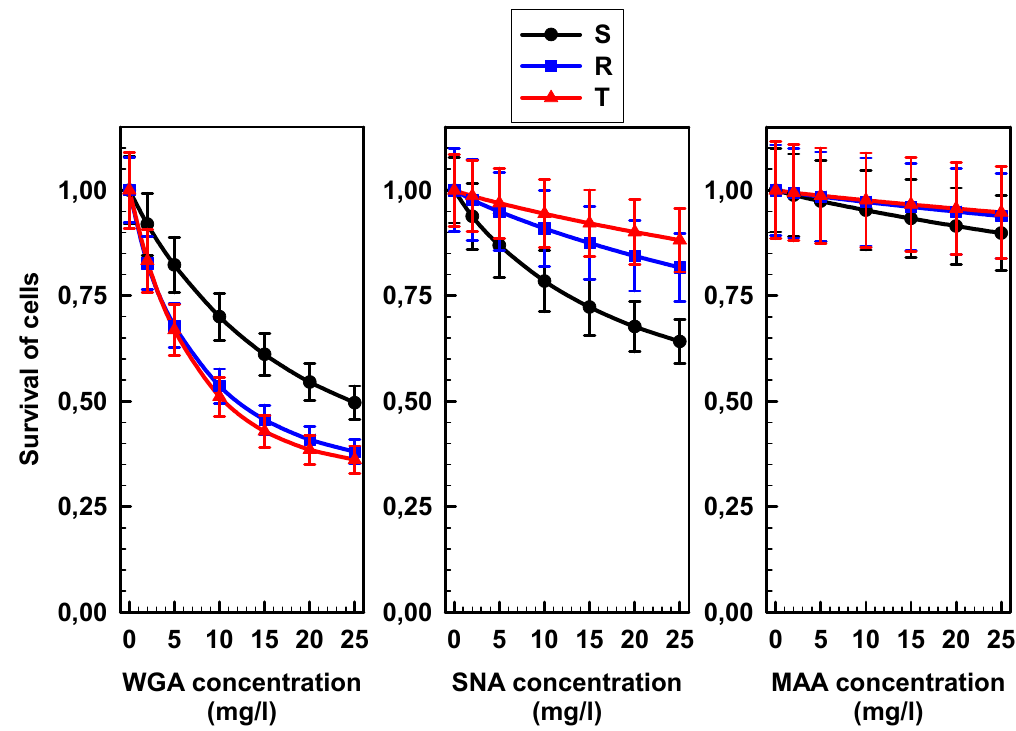
injury to S cells than to R and T cells. Only weak cell death effects were induced by MAA on all three of the L1220 cell variants (Figure 3). Figure 3. WGA, MAA and SNA induced cell death in S, R and T cells. Cell death was assessed after incubation with lectins (see materials and methods) by spectrophotometric MTT test. Control experiment in the absence of lectins was arbitrarily chosen as 1. Data represent mean ± SD from three independent experiments. Cell death effects induced by WGA and SNA in S cells vs. R or T cells were significantly different (0.002 < p < 0.02) for all concentrations tested. In R and T cells, differences in cell death in response to these two lectins were not significant. No significant effects on cell death were observed with MAA in all three L1210 cell